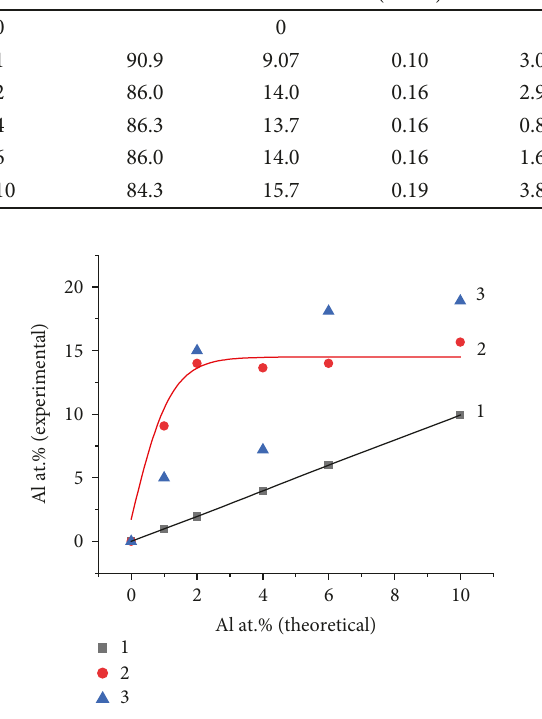
Figure 3: Graphical representation of the Al/Zn ratio in electrolytes and the samples before annealing according to (a) ICP MS data for the electrolytes (1), (b) LAES data (2), and (c) XPS data (3) for 2 μ m- thick fi lms with di ff erent concentrations of (Table 2). On the other hand, the EDX data con fi rm the e ff ect of an increased aluminum percentage in the samples that matches LAES data.